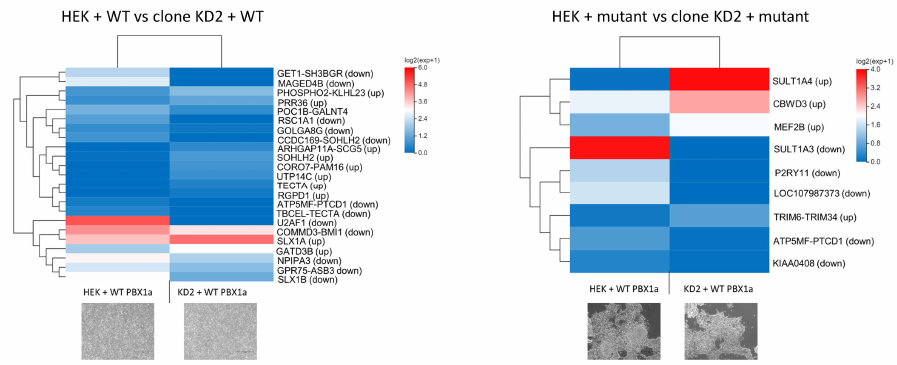
Figure 8. Heatmaps comparing the differential expression between a cell line transfected with WT or mutant PBX1 plasmids. HEK + WT/mutant: WT HEK cells transfected with WT or mutant PBX1a plasmid. Clone KD2 + WT/mutant: KD2 cells transfected with WT or mutant PBX1a plasmid. Up/down: the gene is up/down regulated in cells transfected with mutant plasmid comparing with cells transfected with WT plasmid.